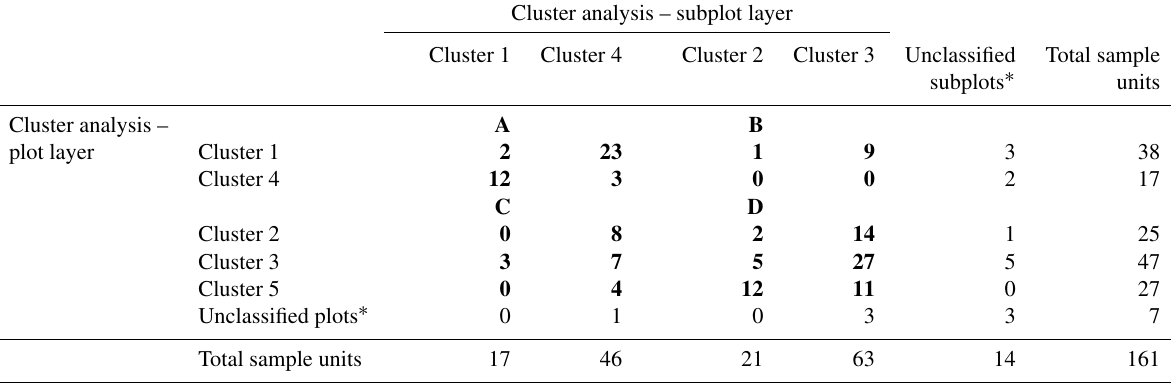
Table H1. Final reconfiguration of canopy tree (main plot) and tree seedling and shrub (subplot) clusters. The numbers in bold refer to the number of sample units (plots and subplots) corresponding to each combination of clusters. The numbers of unclassified sample units and the total numbers are shown in regular font. The letters A, B, C, and D show the final configuration of four woody plant groups: (A) HIGH-SAP;